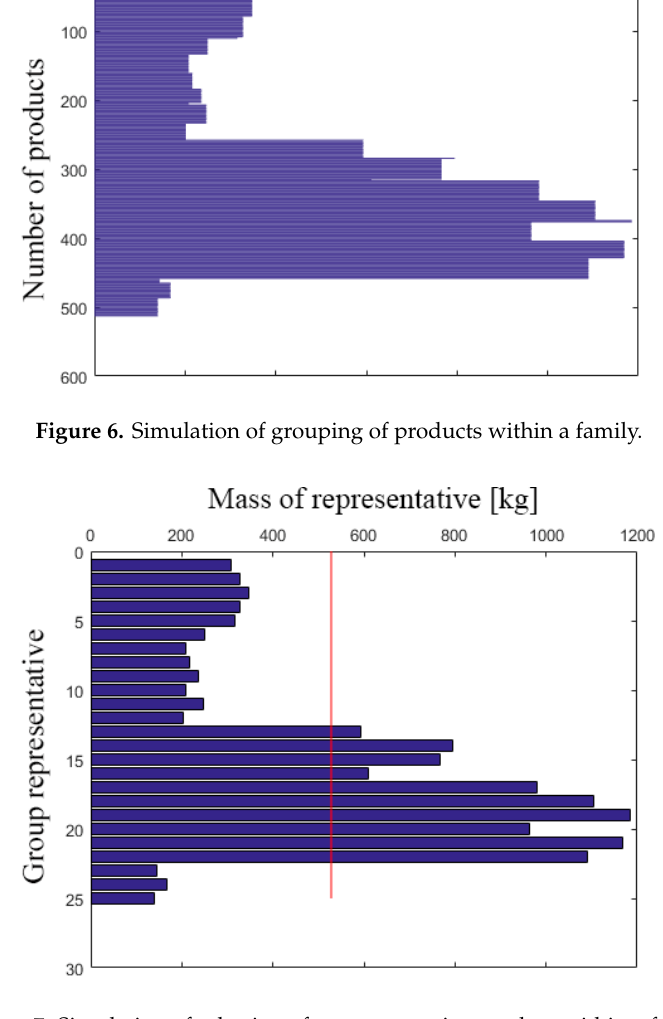
Figure 7. Simulation of selection of a representative product within a family.